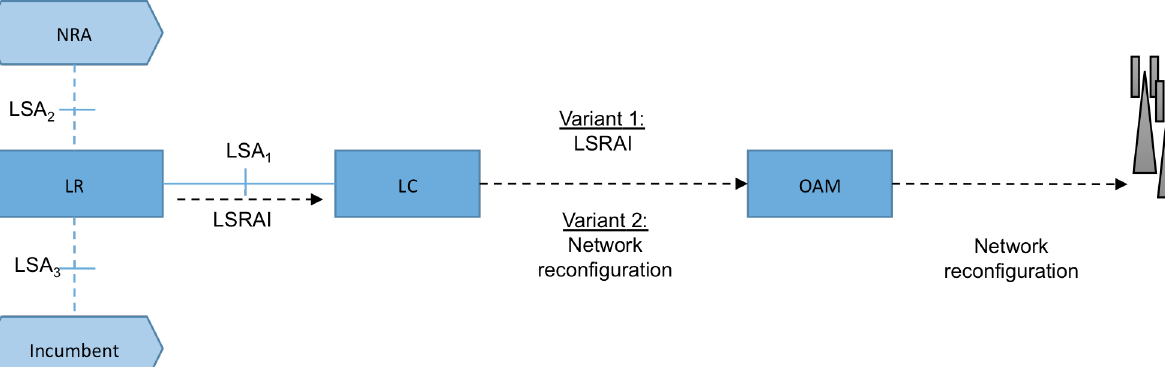
Figure 3. Two variants for LTE RAN network elements reconfiguration under LSA scheme [14,